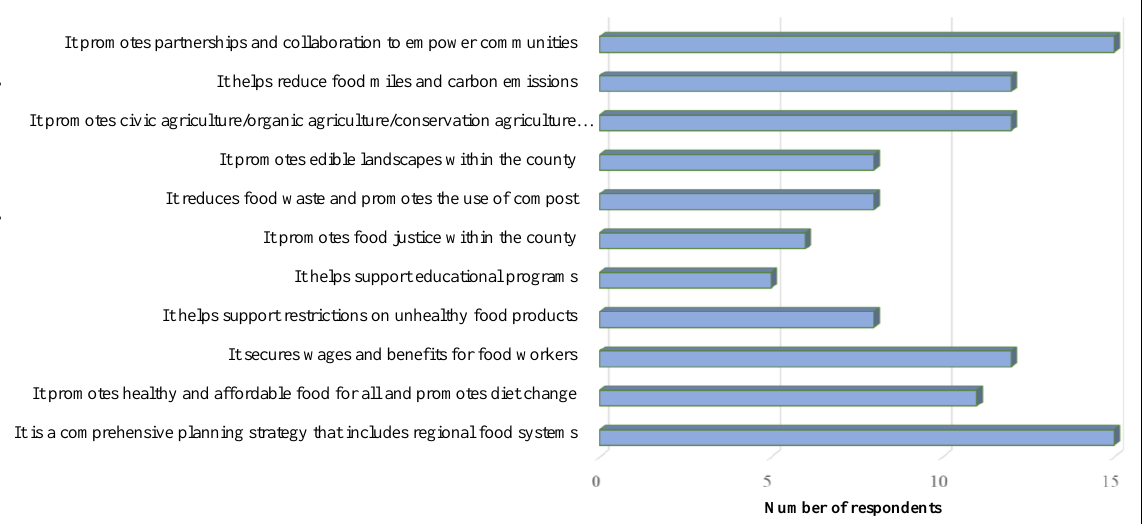
Figure 3. Community-Based Local Food System Characteristics According to Visionary